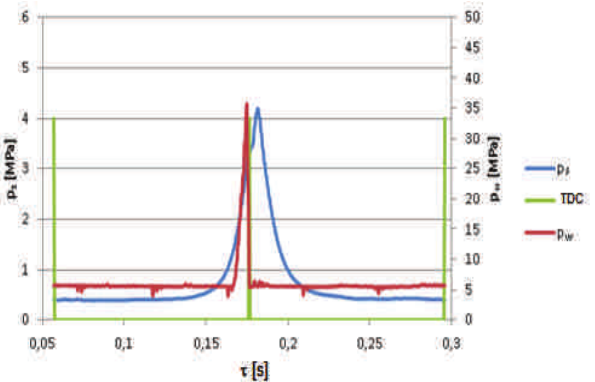
Fig. 3. Course of the pressure in a combustion chamber and the injection pump of the cylinder for one cycle at engine load of the 0%: p s - pressure course in the combustion chamber, TDC - top dead centre, p w - pressure in the injection pump